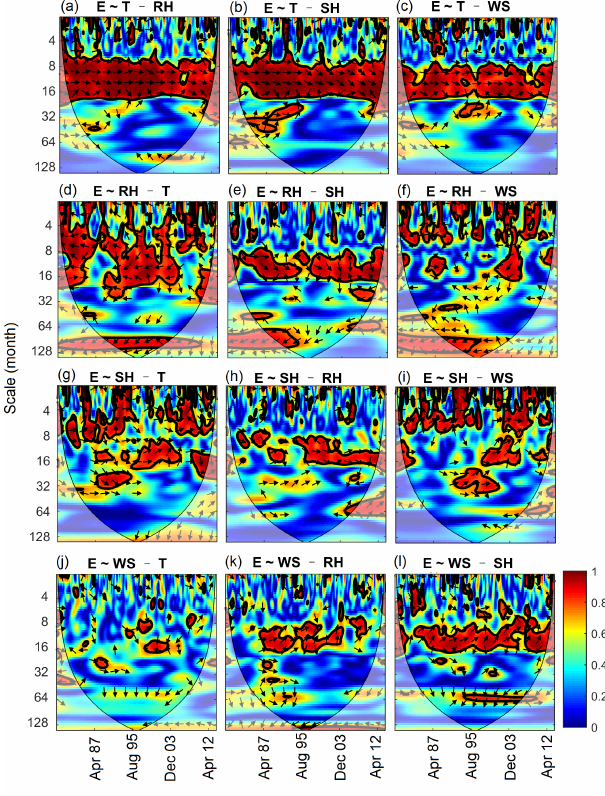
Figure 3. PWC between evaporation ( E ) and each meteorological factor ( T , mean temperature; RH, relative humidity; SH, sun hours; WS, wind speed) after excluding the effect of each of the other three meteorological